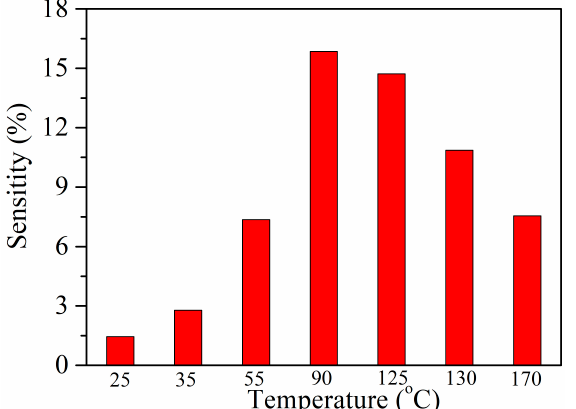
Figure 4. The sensitivity of the Ag–SnO 2 /rGO nanocomposite sensor to 100 ppm acetylene under different operating temperatures.